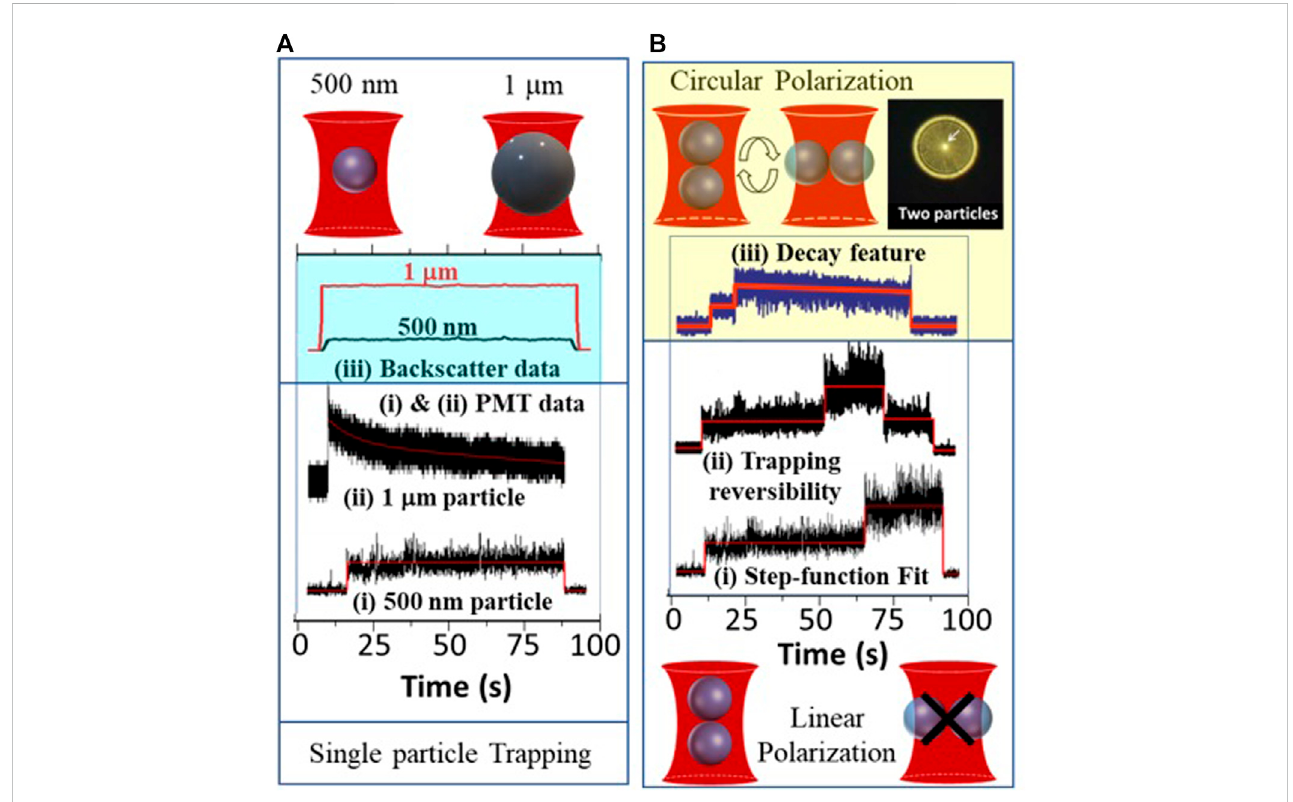
FIGURE 4 Highlighting the characteristics of FOT: (A) Size-dependent TPF signal decay in FOT as shown for (i) 500 nm versus (ii) 1-micron fl uorophore-coated- bead through photo-multiplier tube (PMT) detection, which shows the importance of total versus partial illumination of the tweezed particle. (iii) Same study forbackscatterdataacquisitiondoesnotshowanycharacteristicdecay.GiventhisdistinctionofFOT,itcanbeusedfordeterminingtheorientationofmultiply trappedbeads: (B) Useoflinear versus circularpolarizationintheTPFdataacquisition(i),(ii),and(iii)respectively,fordeterminingthepossibleorientation of the two co-trapped 500 nm